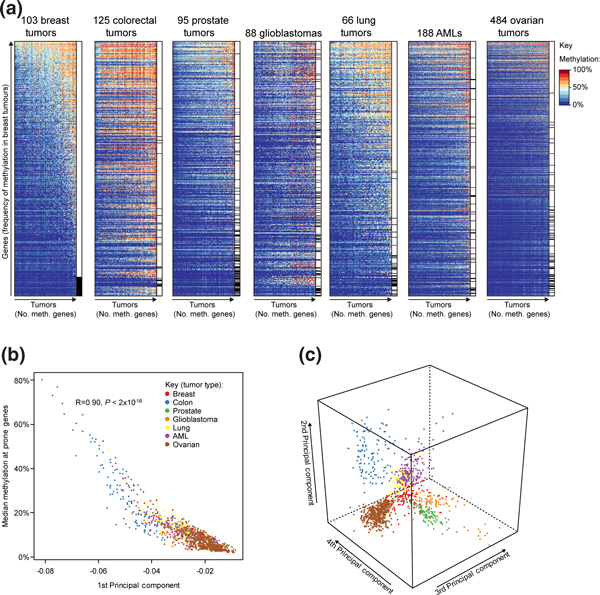
Tissue of origin determines promoter hypermethylation patterns in cancers. (a) Cancer type determines tumor methylation profiles. Shown are heatmaps of methylation levels at the 1,009 hypermethylation prone genes in 7 tumor types. Genes are ordered by their frequency of methylation in breast cancer and tumors by the number of methylated genes. The black tick marks adjacent to the heatmaps indicate genes that are never methylated in that tumor type. (b) Most variation between tumors corresponds to levels of methylation at hypermethylation prone genes. Shown is a scatter plot of the median methylation level at the 1,009 methylation prone genes in each of the 1,149 tumors against its value along the first principal component. Tumors are colored by type. The two values are significantly correlated (R = -0.90, P < 2 × 10-16). (c) Tumor type specific components exist in tumor hypermethylation patterns. Shown is a three-dimensional scatter plot of the values of each of the 1,149 tumors along the 2nd, 3rd and 4th principal components. Tumors are colored by type (as in (b)).